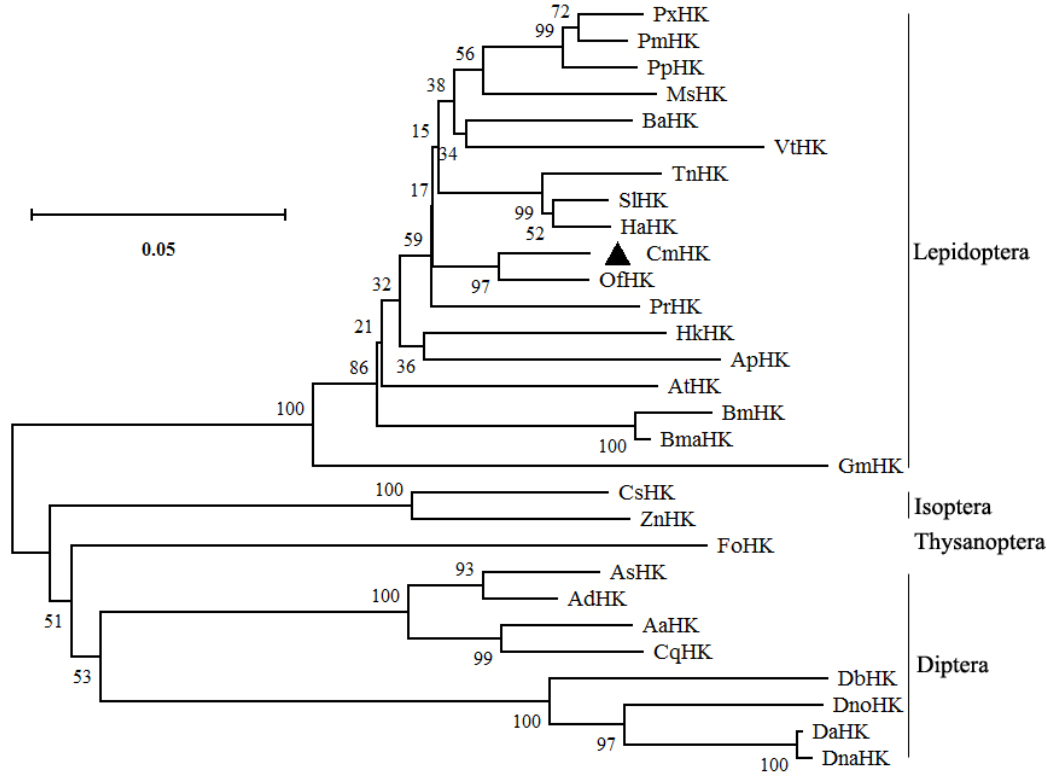
Figure 3. Phylogenetic tree shows the relationship of CmHK with other insect hexokinases. These amino acid sequences were analyzed by Clustal Omega. The tree was constructed using MEGA X. The bootstrap test with 1000 replicates shows the percentage of replicate trees in which sequences are clustered. GenBank accession numbers of different insect HKs are as follows: CmHK (MN612078),